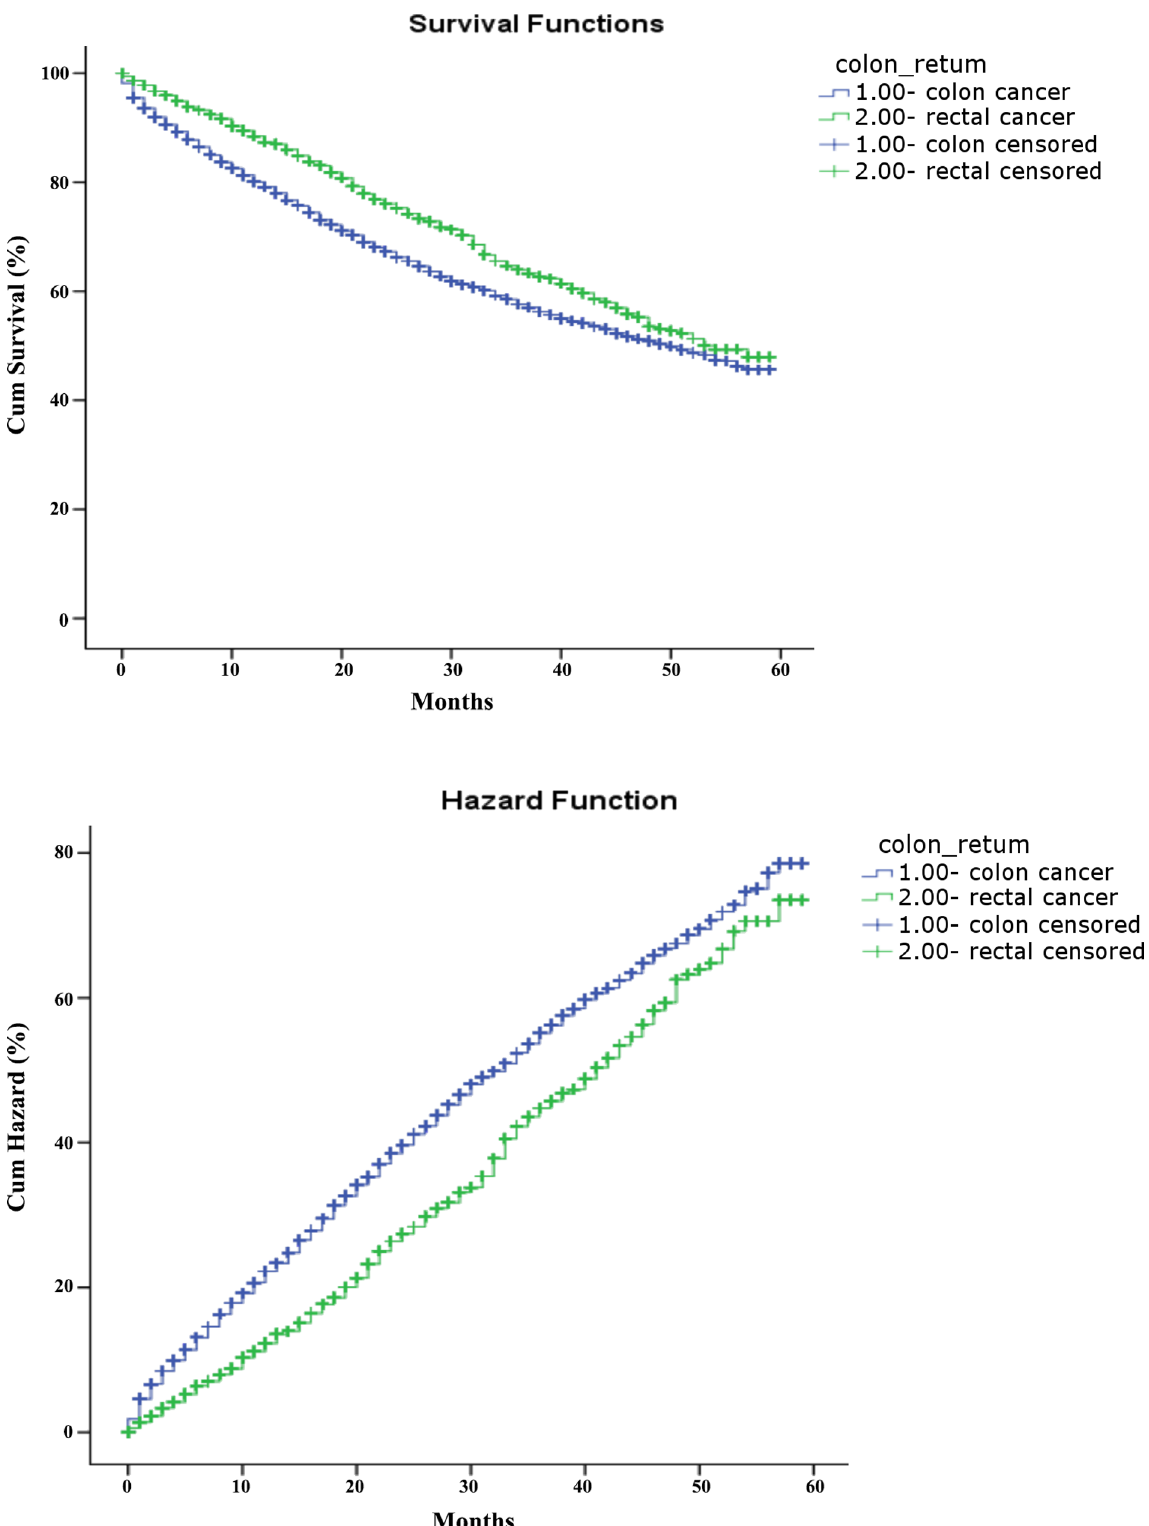
Figure 4. Survival and cumulative hazard of stage IIIC colon and rectal cancer patients (1, colon cancer; 2, rectal cancer).